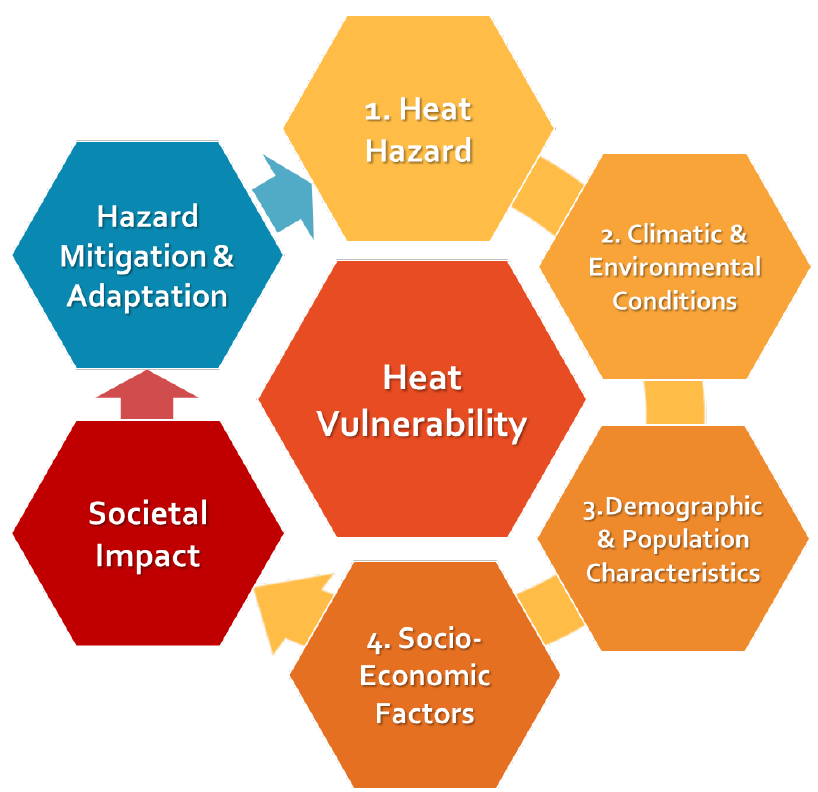
Figure 3. Conceptualizing multi-faceted heat vulnerability. Source: Authors’ own illustration.